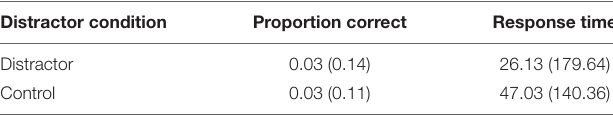
TABLE 3 | Mean PI effect (and SD) for proportion correct and response time in Experiment 3 according to distractor condition. Distractor